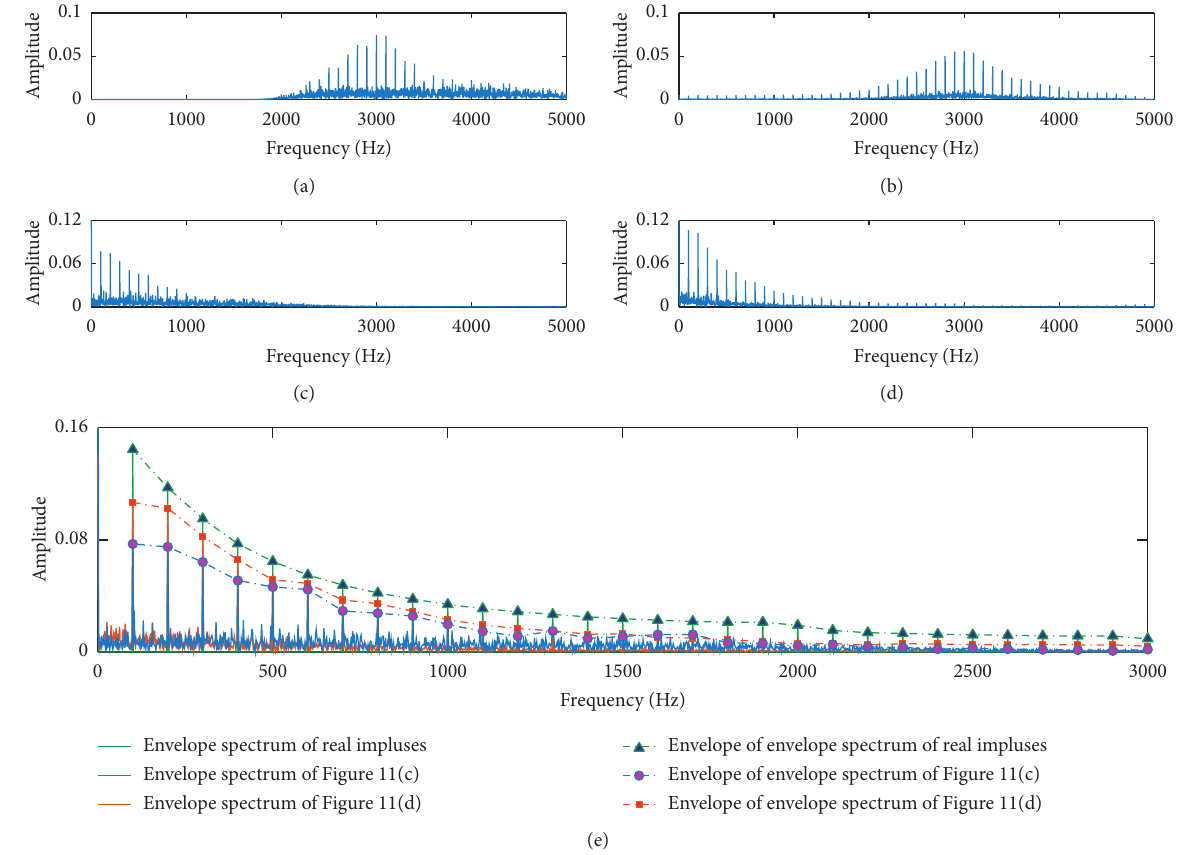
Figure 12: (a) Fourier spectrum of signal in Figure 11(c); (b) Fourier spectrum of signal in Figure 11(d); (c) and (d) envelope spectrums of signals in Figures 11(c) and 11(d), respectively; and (e) comparison between envelope spectrum of real impulses and obtained envelope spectrum (envelope spectrums in Figures 12(c) and